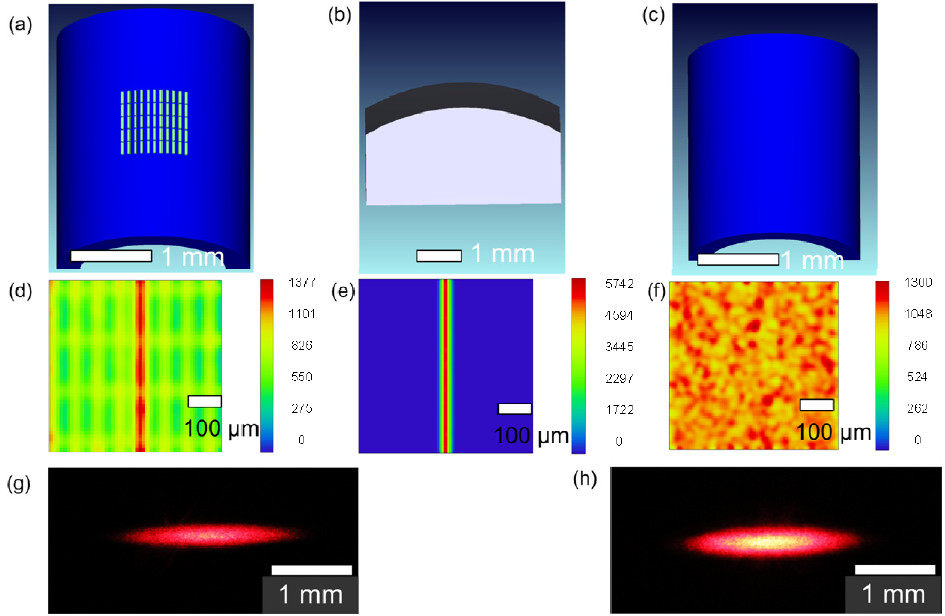
Figure 4. Zemax simulated intensity profiles ( d )–( f ) of various corresponding devices of ( a ) our micro-mirror array on a cylindrical PDMS substrate; ( b ) a conventional cylindrical lens; and ( c ) a cylindrical PDMS membrane itself, with a collimated light source. The device structures in ( a )–( c ) are schematically drawn. Pictures of focused line images produced by ( g ) our device and ( h ) a commercial refractive cylindrical lens. Note that the beam-shaping performances of both focused line images are almost comparable. The wavelength of the laser beam was 633